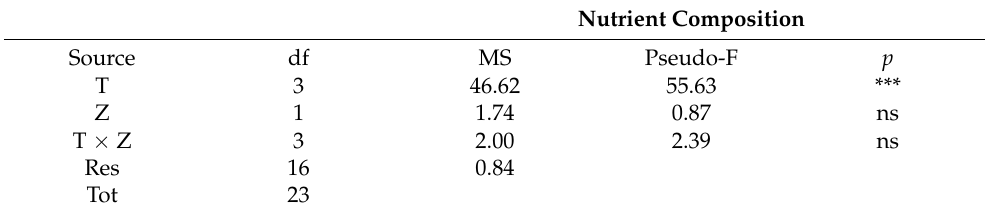
Table 5. Results of the permutational analyses (PERMANOVA) on nutrient composition (ammonia, nitrates, nitrites, total nitrogen, phosphates, total phosphorus, and silicates) in the water columns of W and E zones (Z) among sampling times (T). Abbreviations: Res—residual; Tot—total; df—degrees of freedom; MS—mean squares; Pseudo-F—F critic; P—permutational level of probability. *** p < 0.001; ns—not